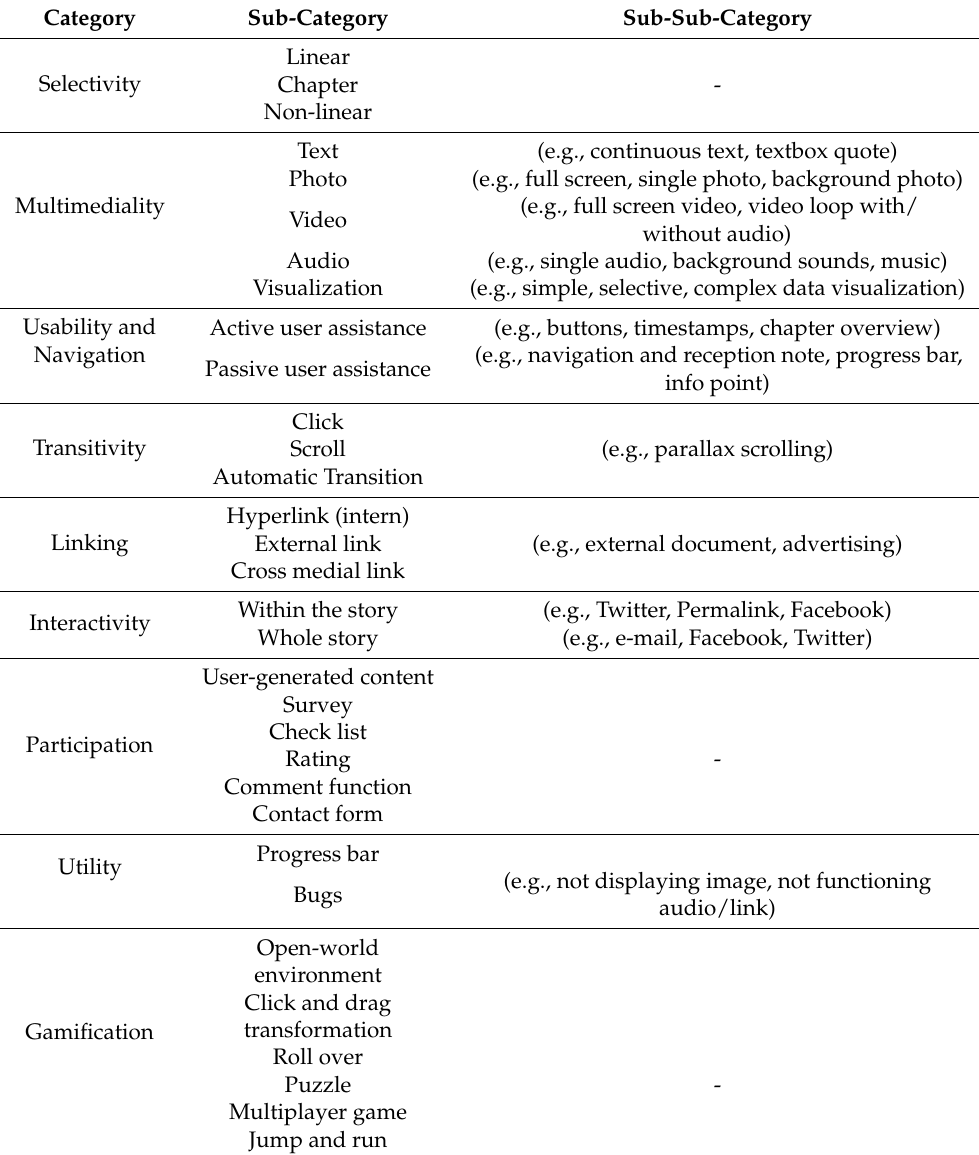
Table 3. Main and subcategories of digital long form stories derived through Grounded